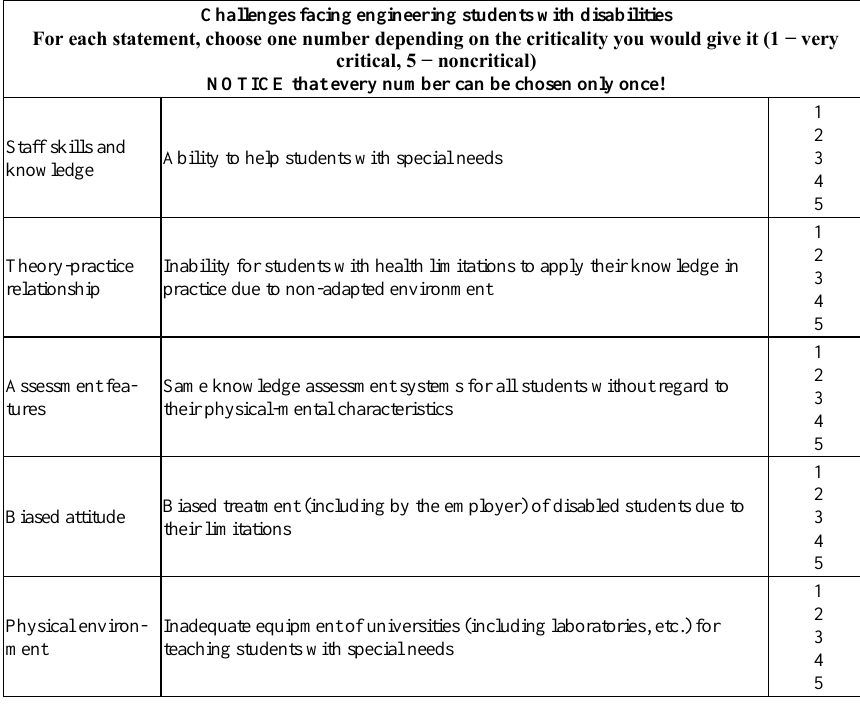
Table 2. Most Common Problems of Disabled Engineering Students